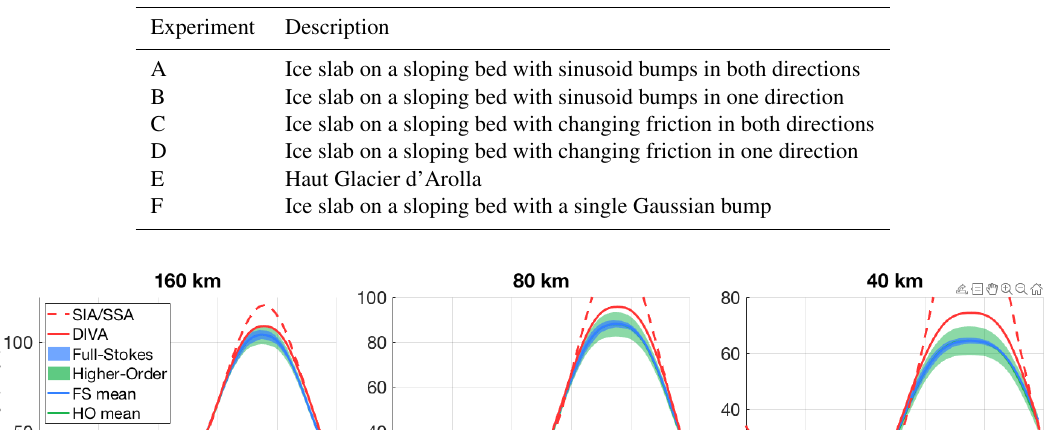
Table 6. The six different ISMIP-HOM experiments.